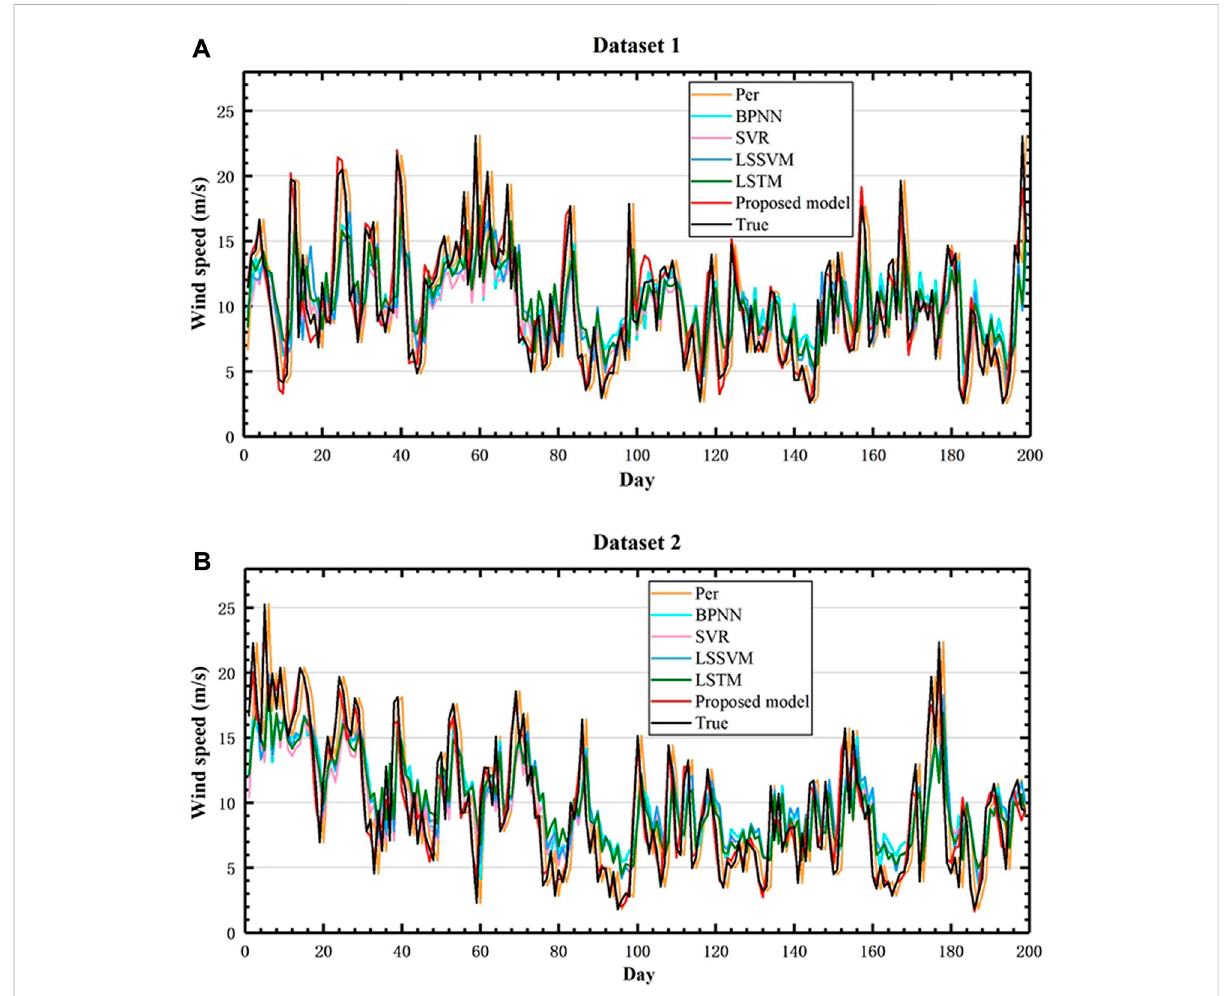
FIGURE 5 The line chart of forecasting results on experiment Ⅰ (A) Dataset 1. (B) Dataset